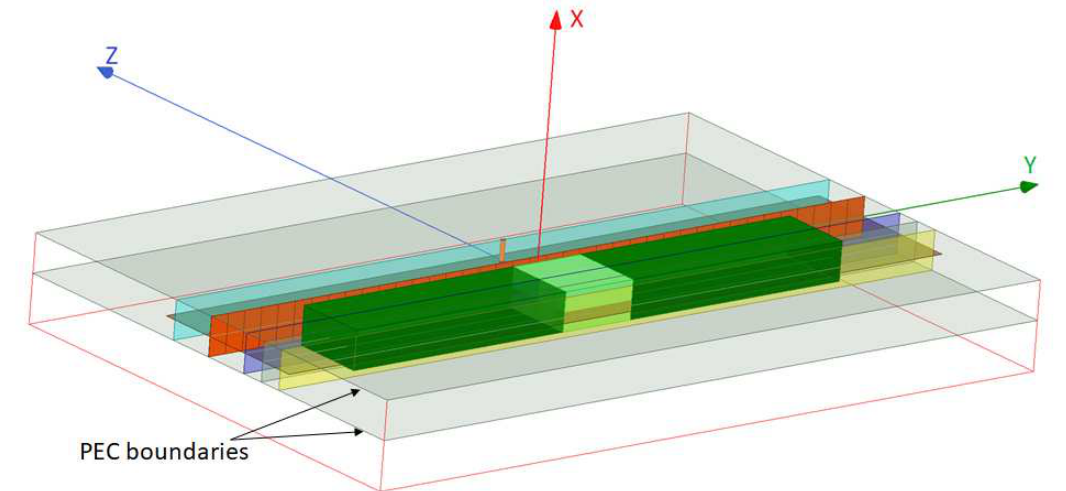
Figure 6. The simulated NF plate (orange plane) setup with a dielectric slab in front of it. The dielectric slab has the size of λ /20 × 2 λ /3 × λ /10. The description of the excitation and receiver planes are the same as Figure 5. The dielectric slab consists of an OI and two undesired scatterers. The OI is the light green box, and the two undesired scatterers attached to the OI are the dark green